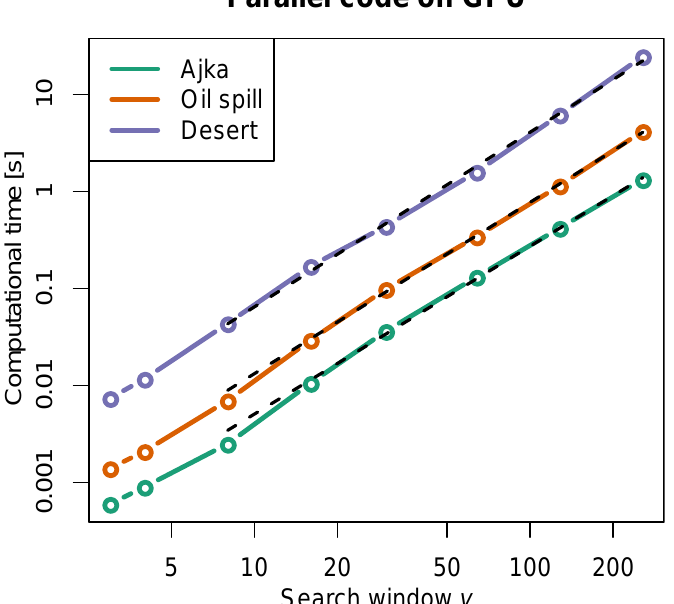
Figure 5. Plot of the computational time of the parallel algorithm on the GPU vs. search window v (similarity window d = 1). Curves refer to the Oil Spill, Desert and Ajka images. The fit by Equation (4) is also shown as a dashed line.